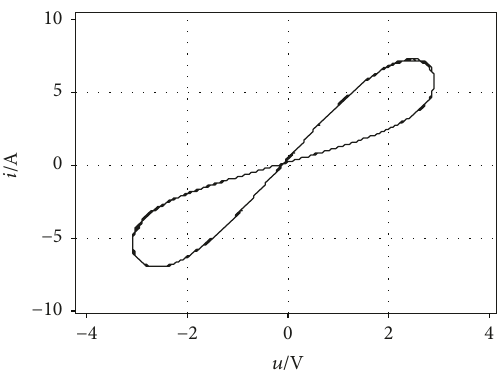
Figure 1: Volt-ampere characteristic curve of the smooth passive fl ux-controlled memristor.